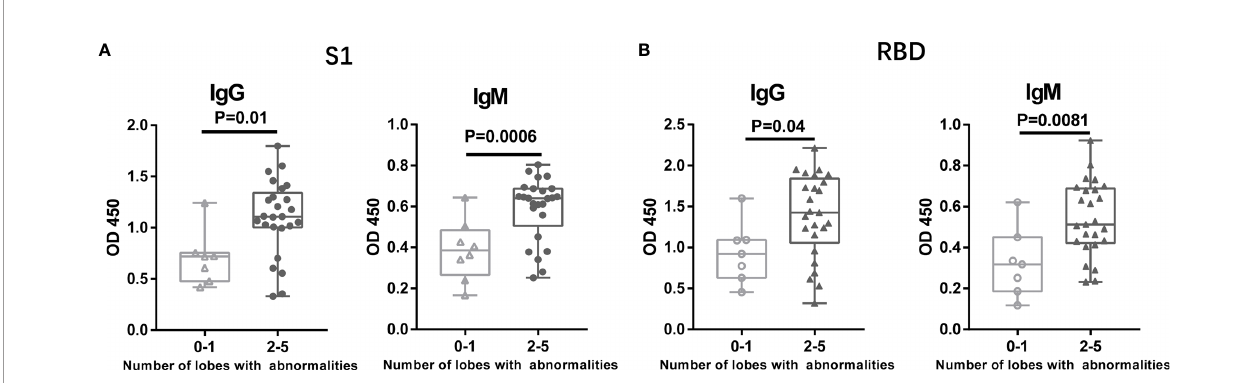
FIGURE 4 | Patients with More Lung Lobes with Abnormalities Developed Higher Levels of Antibodies. The patients were grouped based on the number of based on the number of lung lobes with abnormalities, limited to 1 lobe (0-1), or involved more than 1 lobe (2-5). The plasma samples were collected on the day when the patients detect chest CT. The antibody titers of IgG and IgM antibody against S1 (A) protein or RBD (B) were collect and analyzed.